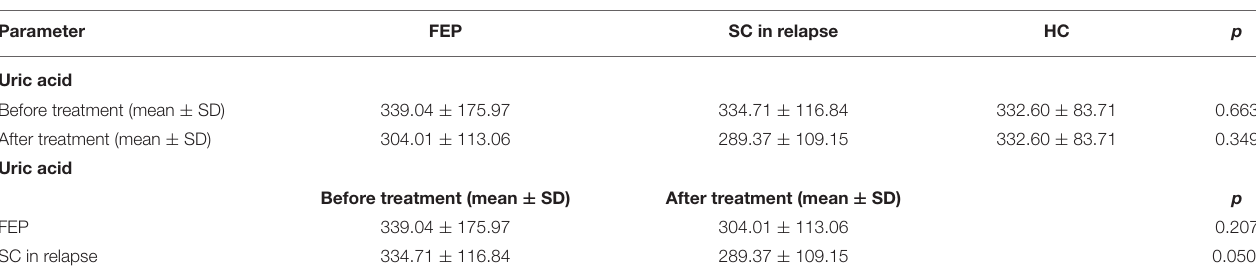
TABLE 2 | Comparison of serum uric acid levels between groups.